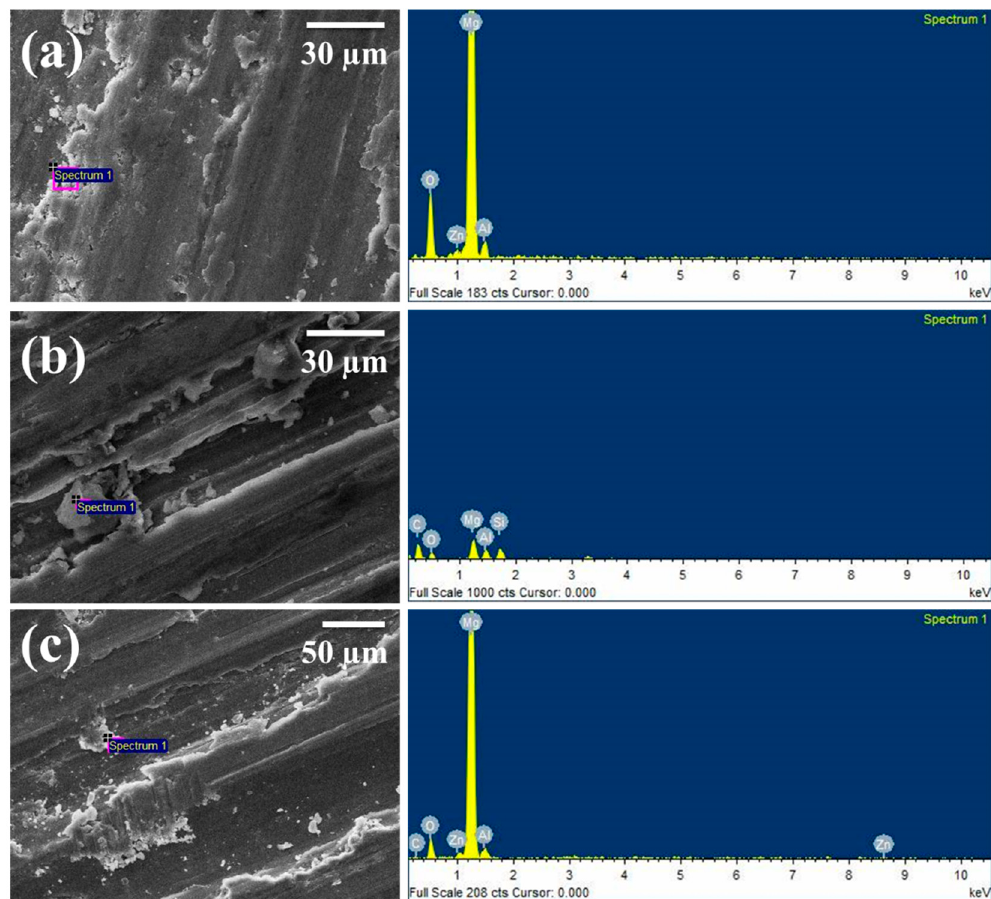
Figure 9. Energy-dispersive X-ray spectroscopy of worn surfaces composites: ( a ) 19.62 N, 1.30 m/s and 0% SiC; ( b ) 39.24 N, 1.3 m/s and 6% SiC; ( c ) 58.86, 2.6 m/s 9% SiC.